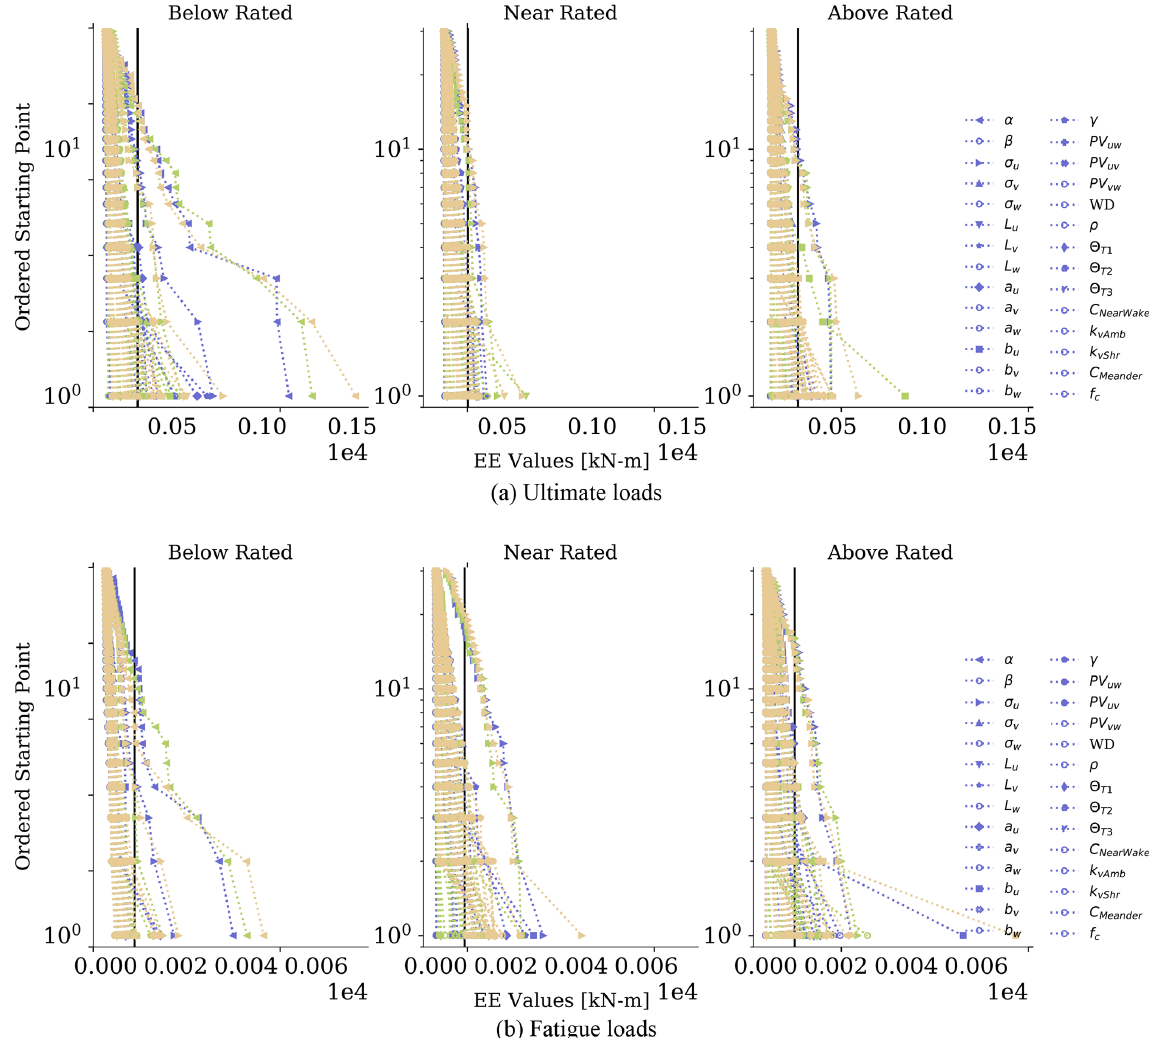
Figure 4. Exceedance probability plot of (a) ultimate and (b) fatigue load EE values for blade-root pitching moments. Each subplot shows a different wind speed bin. Each line represents a different input parameter and wind turbine (blue for WT1, green for WT2, and yellow for WT3). Each symbol represents a different point in the hyperspace, with the same symbols being used for each wind turbine (line color). Unique symbols are used for parameters that primarily contributed to the significant events count. The vertical lines on each plot correspond to the threshold value used to identify significant